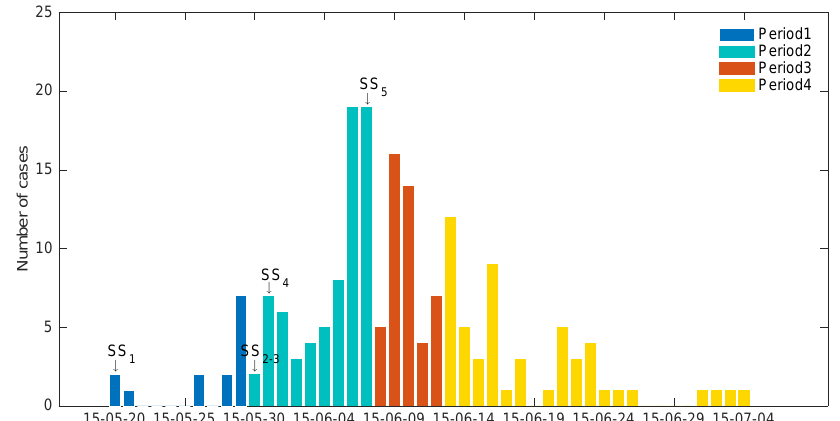
Figure 1. Time series of 2015 Middle East respiratory syndrome coronavirus (MERS-CoV) cases are displayed and classified by generations ( top ) and by intervention periods ( bottom ). The index case with 28 cases; the second generation with 111 cases; the third generation with 22 cases; the fourth generation with 1